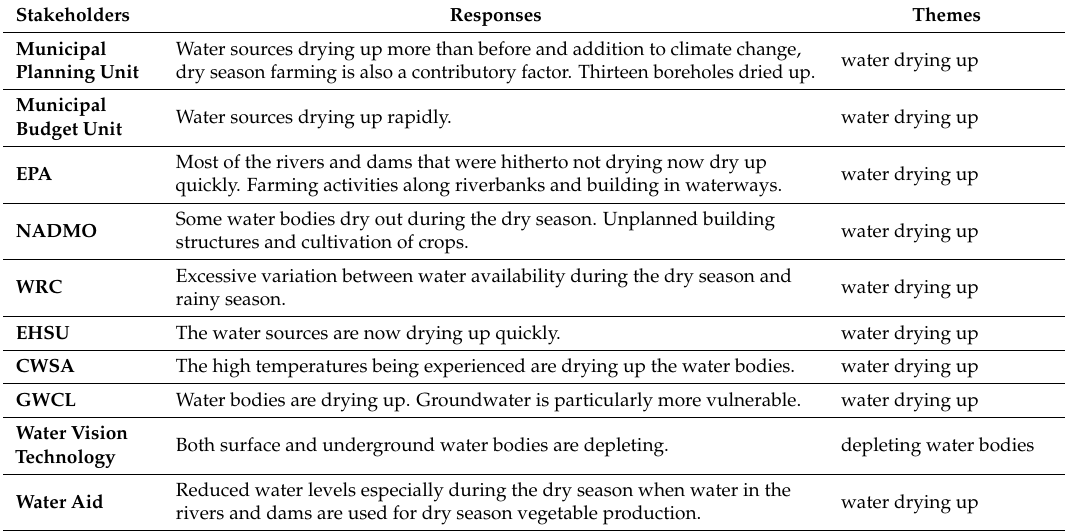
Table 2. Stakeholder perspectives of the impact of climate change on water resources.